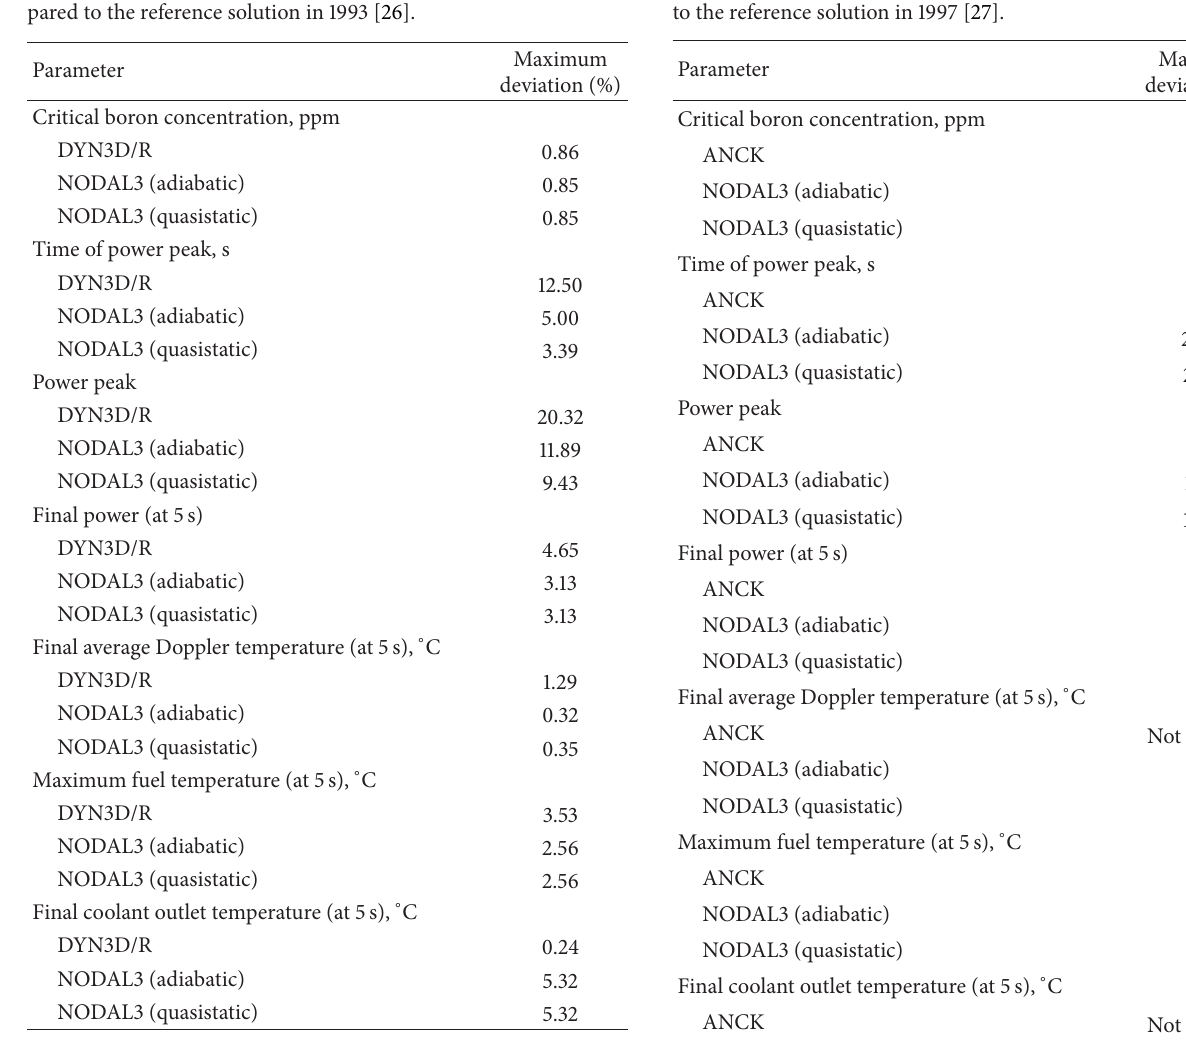
Table 3: Maximum deviations of DYN3D/R and NODAL3 com- pared to the reference solution in 1993 [26].